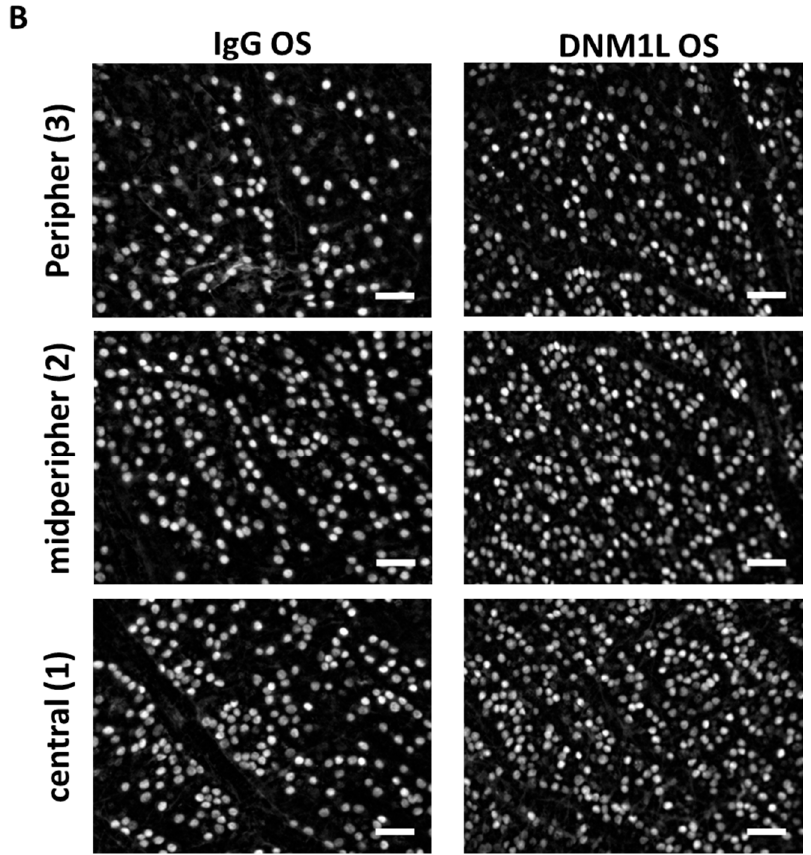
Figure A1. Immunofluorescence staining of RGCs with Brn3a. ( A ) Example of a retinal flatmount with RGCs stained by indirect immunofluorescence of Brn3a. The flatmount is divided into three sections: central (1), mid-periphery (2), and periphery (3). Scale bar: 1 mm. Three images are recorded within each region. Calculating the RGC count was performed by summing up the individual count of each image and then dividing by the number of images included. For regional analysis of the RGC count, the RGC count of three images of each region is summed up and divided by the number of images used for calculation. ( B ) Representative Brn3a stained images of each region. IgG OS group (left panel), DNM1L OS group (right panel). Scale bar: 50 µm.